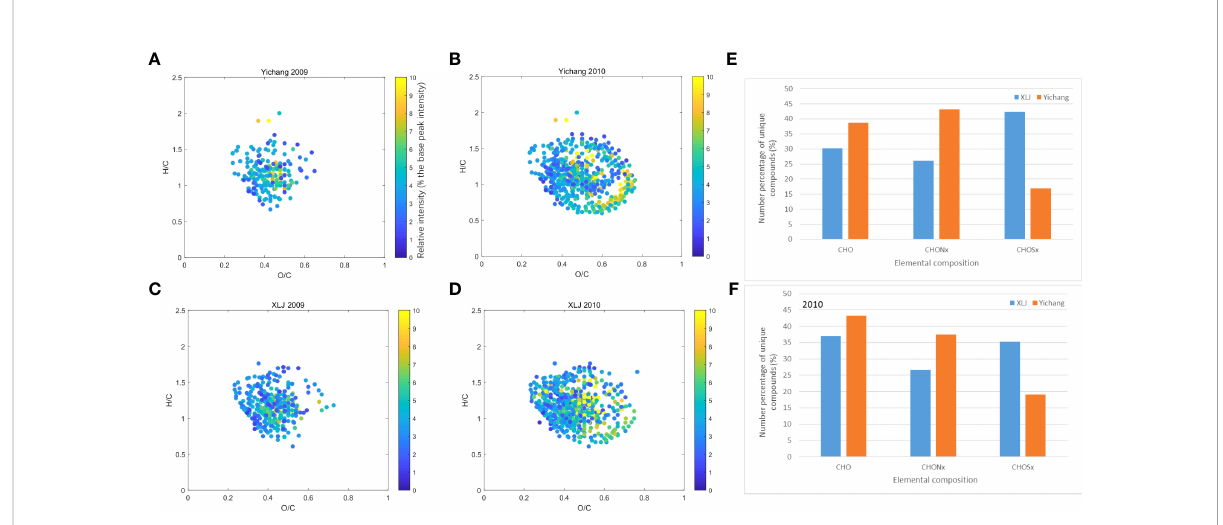
FIGURE 2 (A – D) , van Krevelen diagrams of unique formulas from two stations Yichang (YC) and Xuliujing (XLJ). The color bar represents the relative intensity of each formula; (E, F) Comparison of number percentage of unique compounds for each of the two